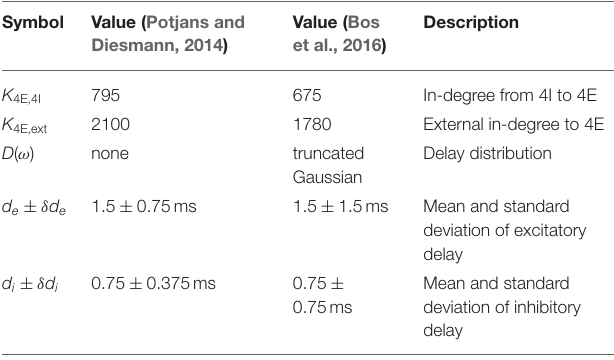
TABLE A1 | Microcircuit